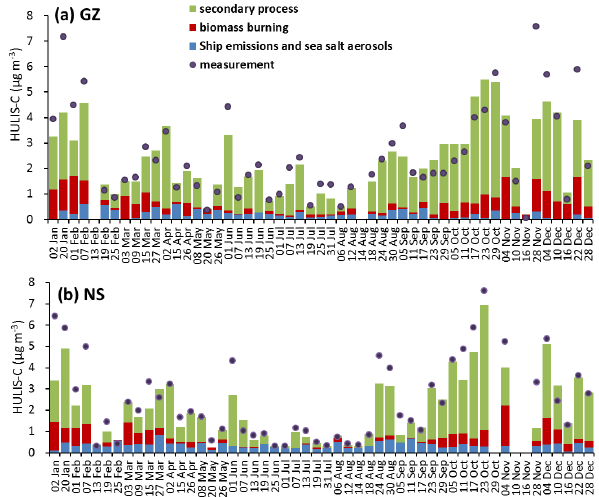
Figure 6. Spatial and temporal variation of source contributions by each factor for